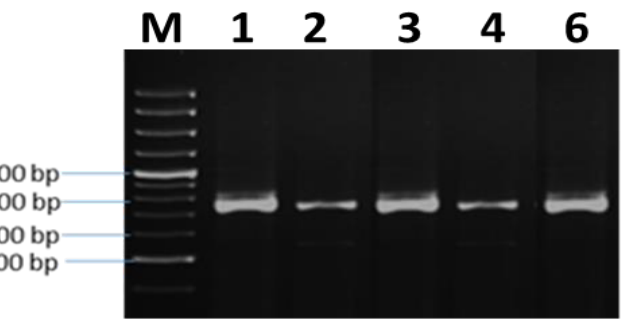
Figure 2. Agarose gel electrophoresis of the amplified PCR fragment for the ITS gene. M: 1 kb DNA marker, isolates with code no. (1, 2, 3, 4 and 6).